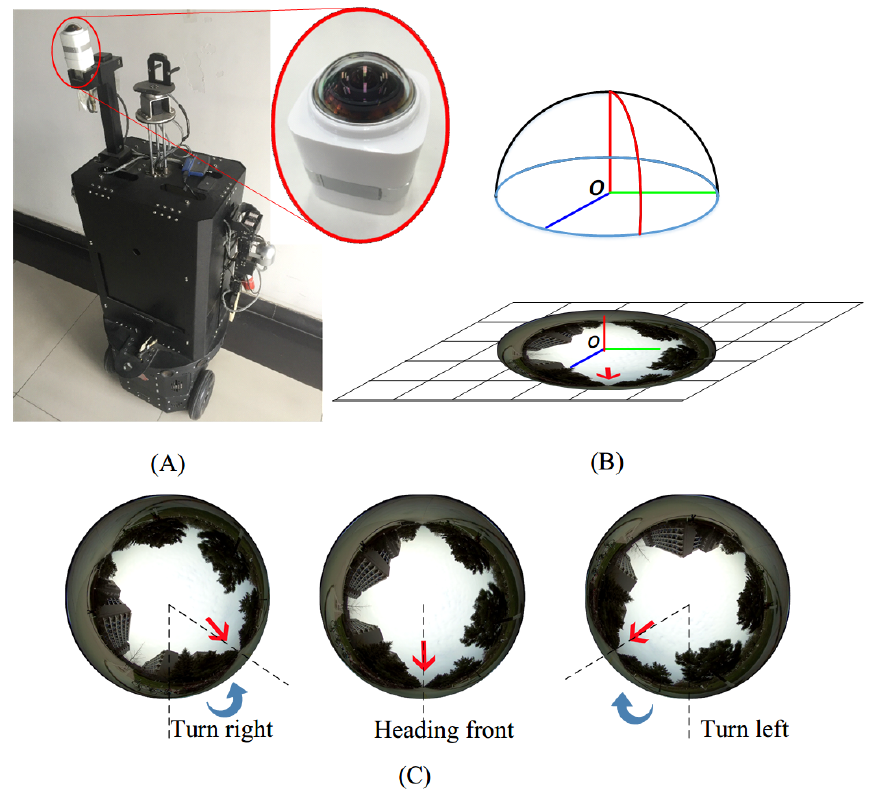
Figure 1. ( A ) A spherical camera mounted on a ground robot platform. ( B ) The spherical camera coordinate systems and its imaging model. Natural scenes are warped into the circular fisheye image. ( C ) Samples of captured spherical images. Red arrows denote the detected optimal path. Our objective is to generate navigation signals (denoted by blue arrows, i.e., steering direction and angles) based directly on these 360 ◦ fisheye